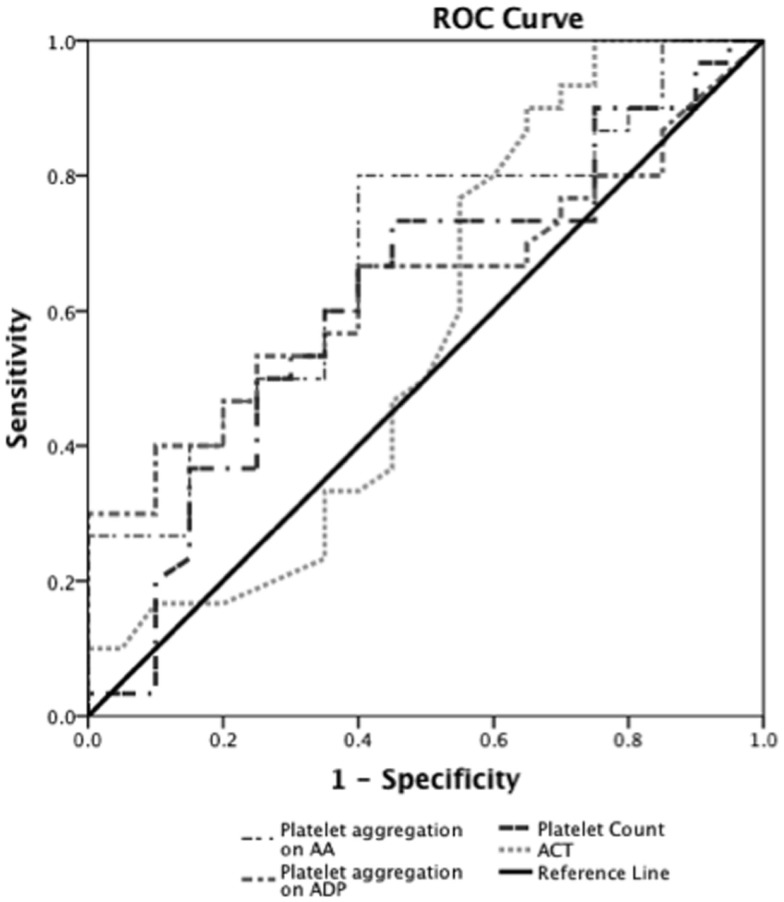
Receiver operator curve analyses for hemostatic parameters to predict severe bleeding. On ROC analyses (n = 24), we found that the AUC for ACT was lowest at 0.56 (0.39–0.75, p = 0.42) and platelet count was 0.61 (0.45–0.78, p = 0.16). The AUC for ADP-mediated platelet aggregation 0.64 (0.48–0.79, p = 0.11) and AA-mediated platelet aggregation 0.68 (0.53–0.83, *p = 0.03).*p < 0.05 considered significant.